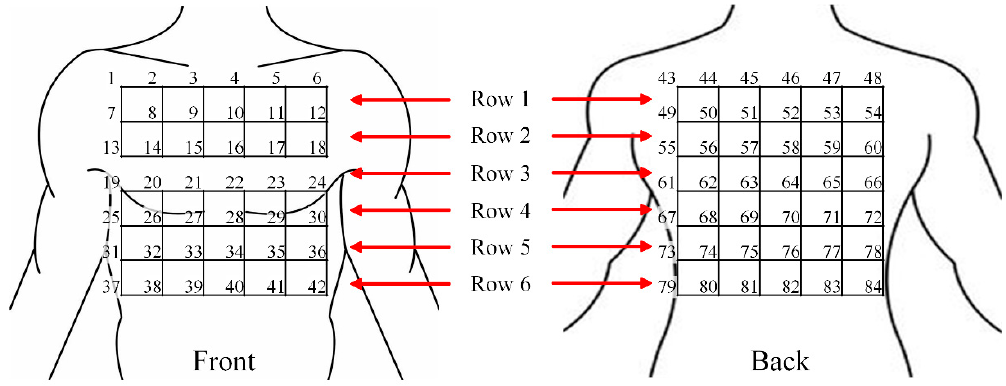
Figure 3. Torso segmentation for the front and back side of the human body.